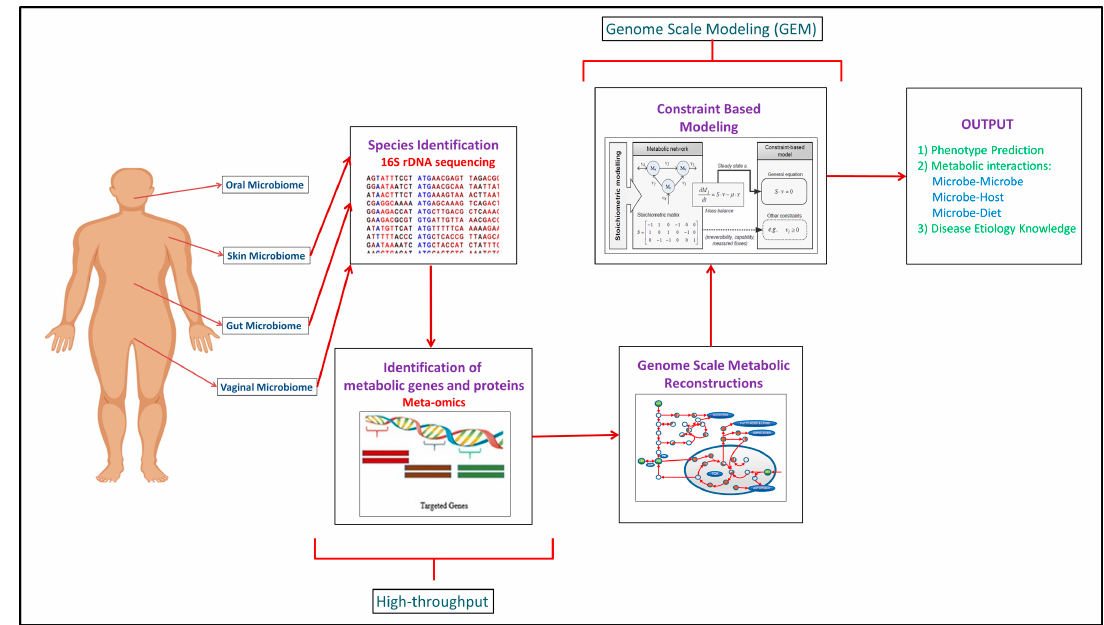
Figure 1. Complete human microbiome research pipeline established over the years explaining the integration of experimental and computational methodologies to get the mechanistic understanding of the human